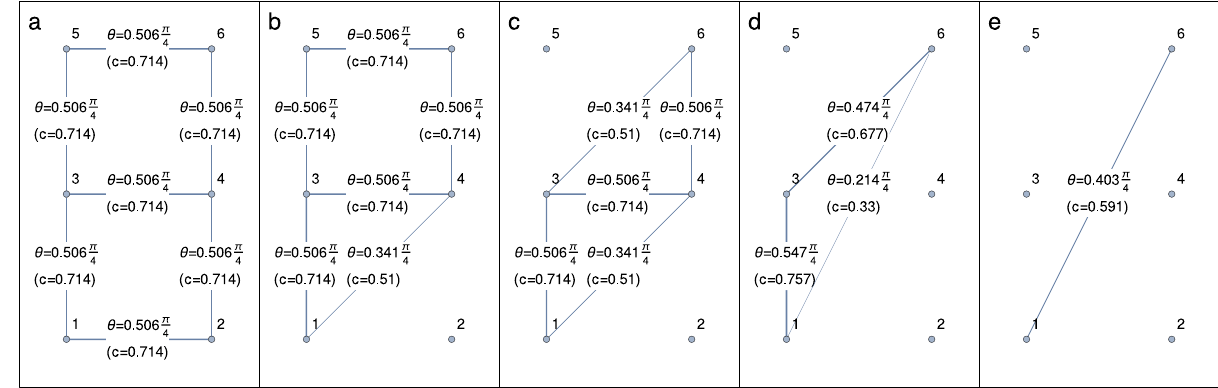
Fig. 2 Demonstration of calculating the s - t concurrence C st . The s - t concurrence between nodes 1 and 6 on a 2D rectangular lattice can be calculated using ConPT, in the order from ( a ) to ( e ). The edge weight θ characterizes the entanglement strength between a pair of entangled particles shared between nodes (Eq. 1) and c (cid:3) sin2 θ refers to the corresponding concurrence. a Original lattice. b , c Series rules. d Star-mesh transform on the star-graph (edges 4 ↔ 1, 4 ↔ 3, 4 ↔ 6), then parallel rule for edges 1 ↔ 3 and 3 ↔ 6. e Series rule for edges 1 ↔ 3 and 3 ↔ 6, then parallel rule for edge 1 ↔